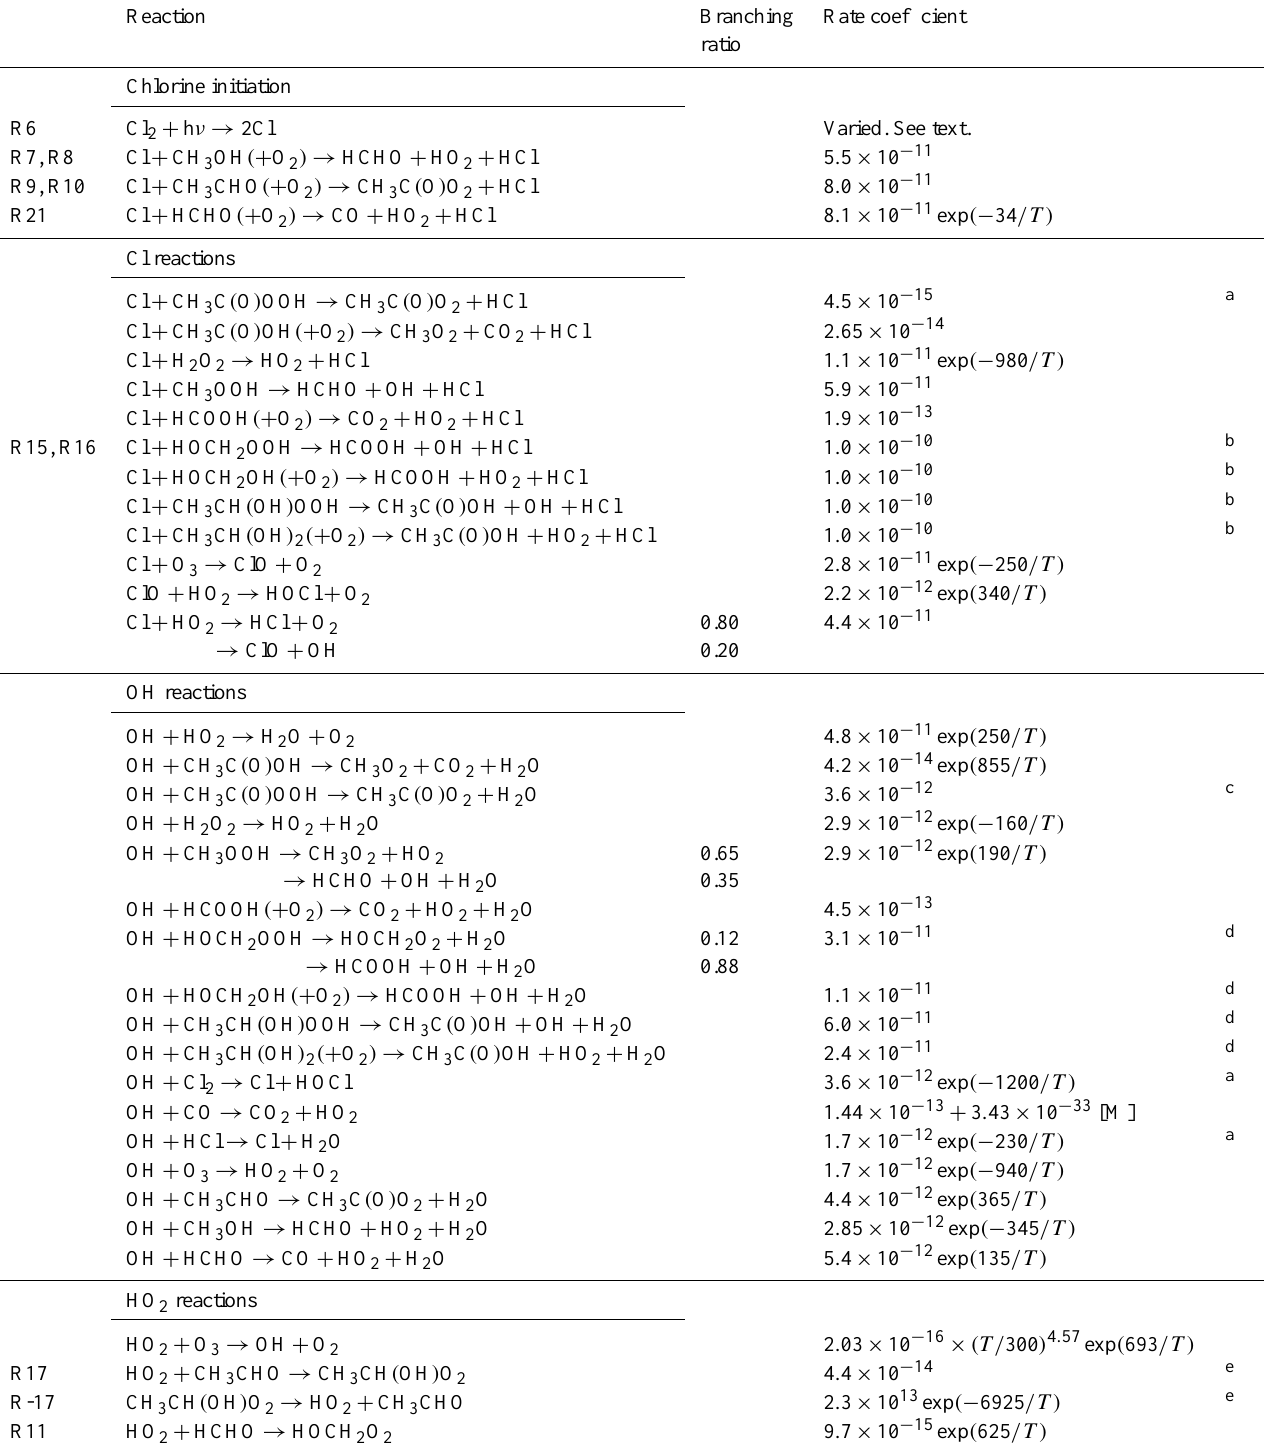
Table 2. Reaction scheme used in the determination of branching ratios for the reaction of CH 3 C(O)O 2 with HO 2 . RO radical decomposition and reaction with O 2 are assumed instantaneous, indicated by ( + O 2 ) where appropriate. Rate coefficients sourced from IUPAC recommended values unless otherwise stated, all quoted in molecule − 1 cm 3 s − 1 (Atkinson et al.,